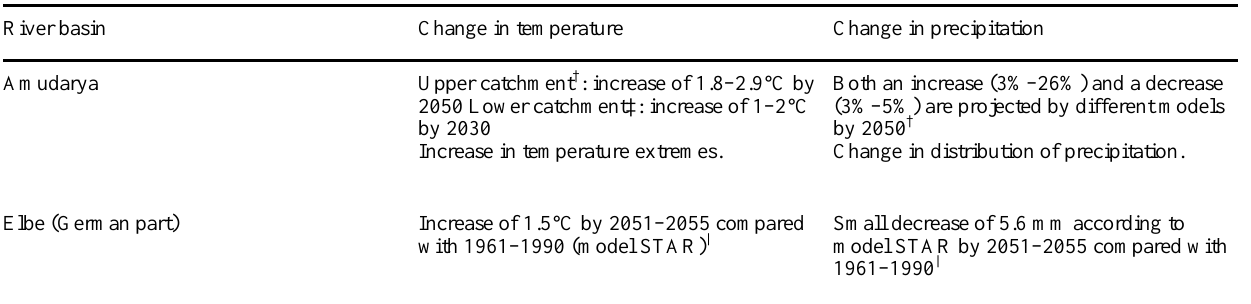
Table 5B. Projected climate scenarios for these